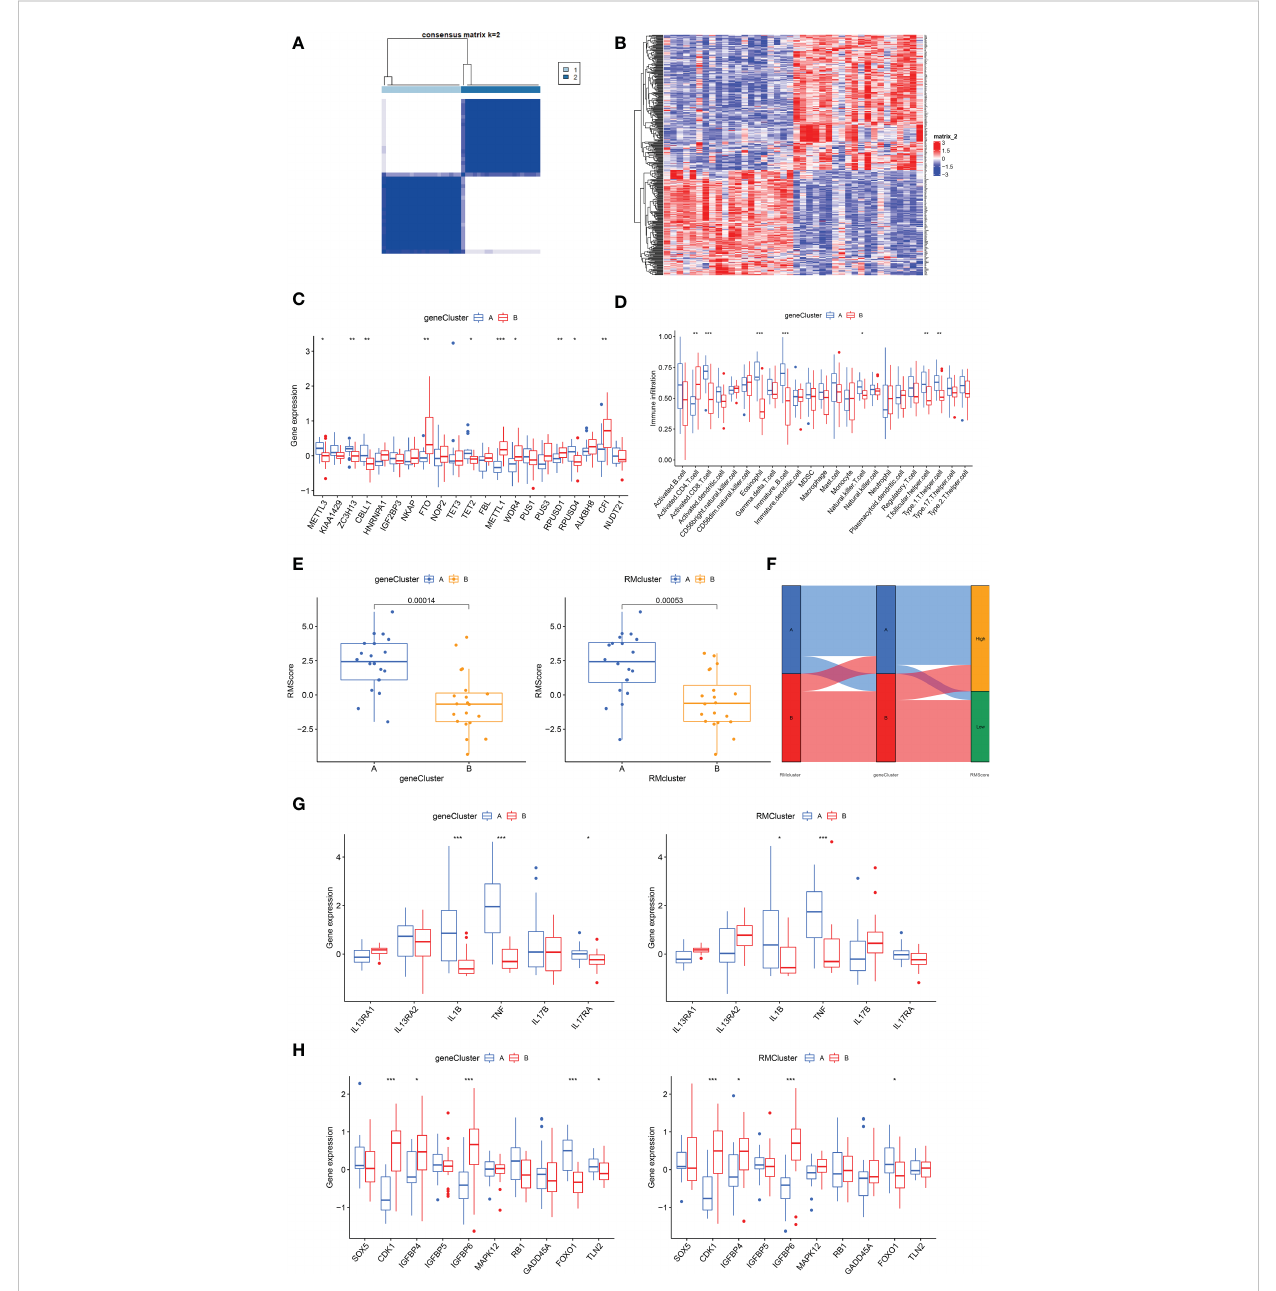
FIGURE 5 Construction of RNA modi fi cation regulator signatures. (A) Consensus clustering matrix of overlapping RNA modi fi cation regulators phenotype- related genes in OA patients for k=2. The OA patients were classi fi ed into different genomic subtypes, termed as gene clusters A and B. (B) Heatmap showing the RM cluster differential gene expression for the two gene clusters A and B. (C) Boxplot showing the expression of RNA modi fi cation regulator differential genes between OA and normal samples. (D) Boxplot showing the in fi ltrating immune cells in the two gene clusters. (E) The Rmscore in the two gene clusters and RM clusters. Kruskal-Wallis tests were applied for testing statistical differences. (F) Alluvial diagram showing the changes of RM clusters, gene clusters and Rmscore. (G) Boxplot showing the immune-related gene expression in the two gene clusters and RM clusters. (H) Boxplot showing the senescence-related gene expression in the two gene clusters and RM clusters. (for all fi gures, * represents p <0.05, ** represents p <0.01, *** represents p <0.001) OA, osteoarthritis; RM, RNA modi fi cation; Rmscore, RNA modi fi cation